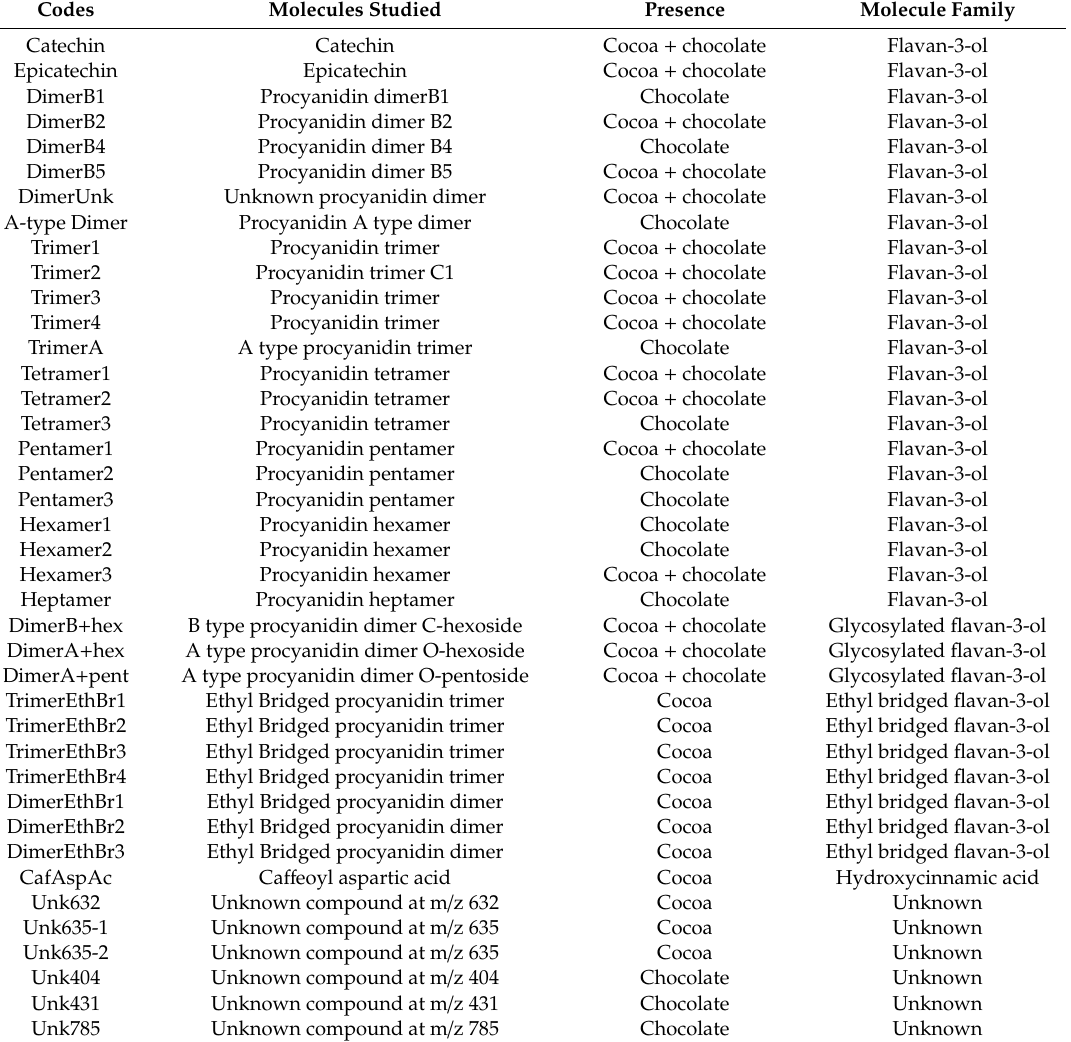
Table 3. List of the di ff erent polyphenol variables analyzed in this